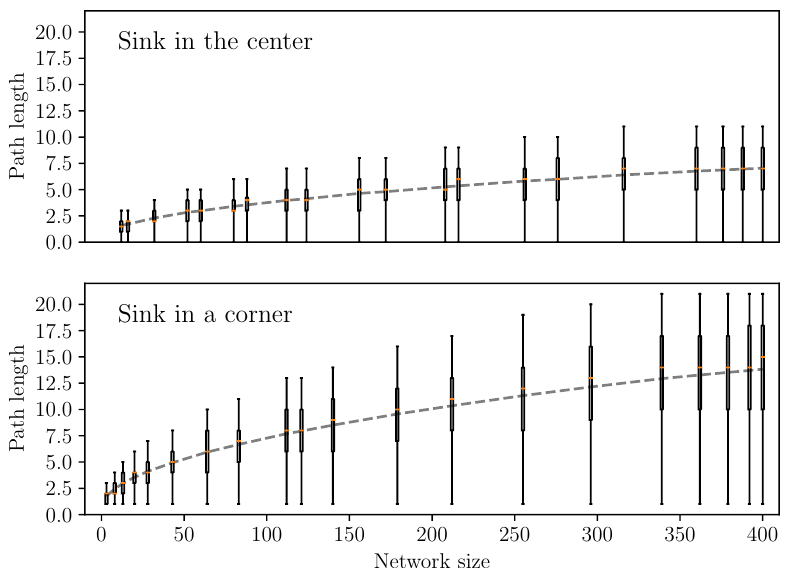
Figure 20. Path length to the sink for each node according to the network size. The dashed curve shows the mean path